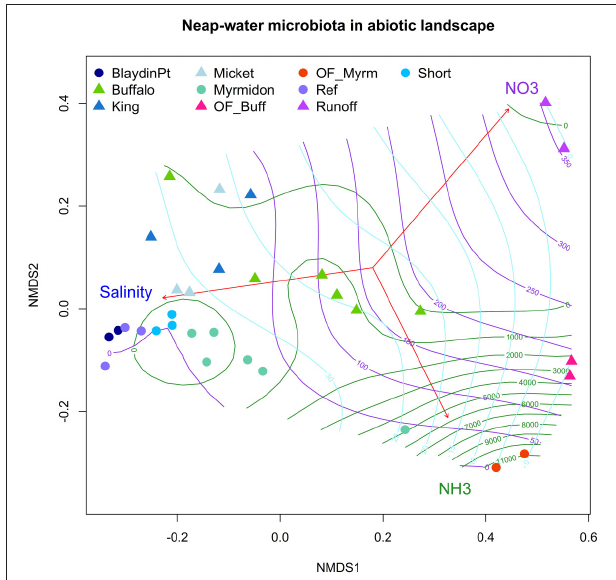
FIGURE 3 | Water microbiota in the nutrient landscape. A nMDS ordination on the site-averaged weighted UniFrac distance matrix of the neap water microbiota in Shoal Bay and East Arm. The function envfit (library vegan in R) was used to plot the correlation vectors between nitrate, ammonia, salinity and the nMDS axes. The contour-lines mark the ammonia (green), nitrate (violet) and salinity (light blue) landscape which was calculated using a non-linear generalized additive model and thinplate spline interpolation implemented in the function ordisurf of the library vegan in R.